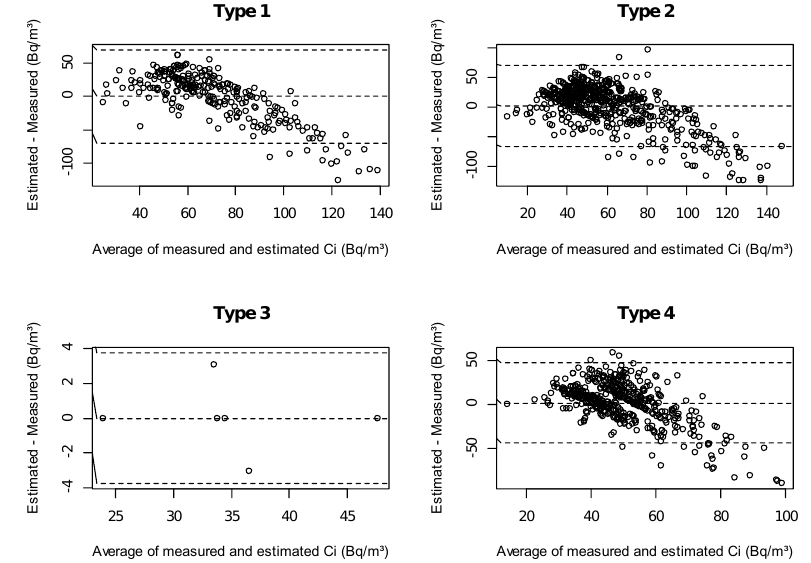
Figure 2. Comparisons of calculated and estimated values of indoor radon concentrations according to residence characteristics.